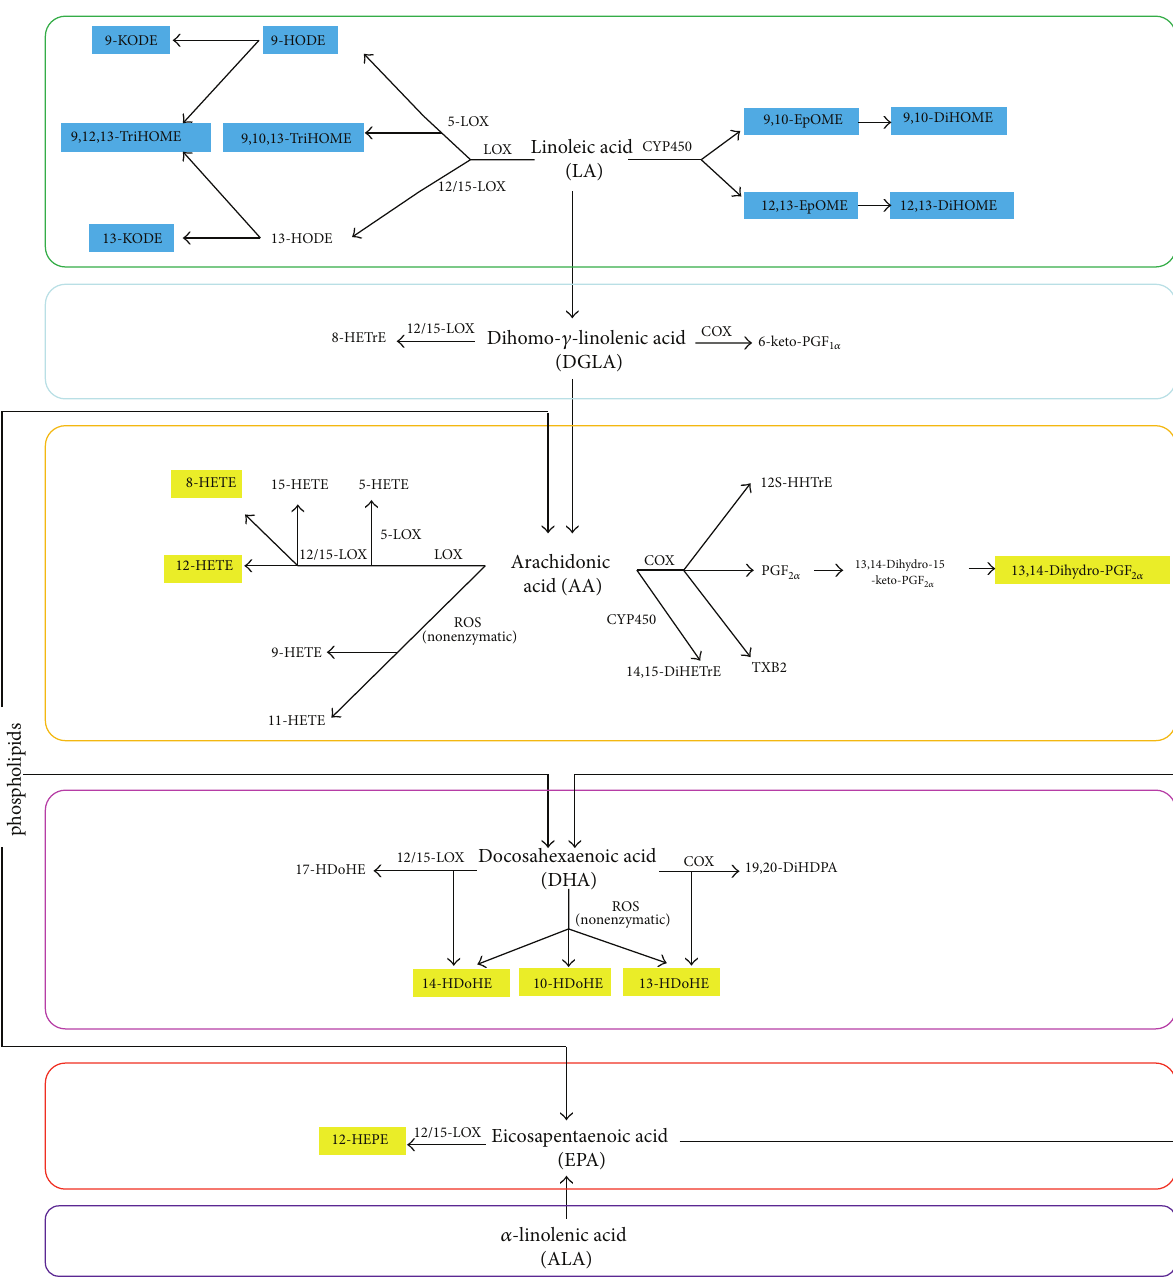
Figure 3: Overview of regulations of oxylipins in CIA mice compared with Ctrl, including metabolic pathways. Metabolites detected in mice plasma are grouped by metabolic pathways. Important metabolites which contribute most to group clustering based on PLS-DA are colored: yellow box: upregulated in the CIA group; blue box: downregulated in the CIA group.